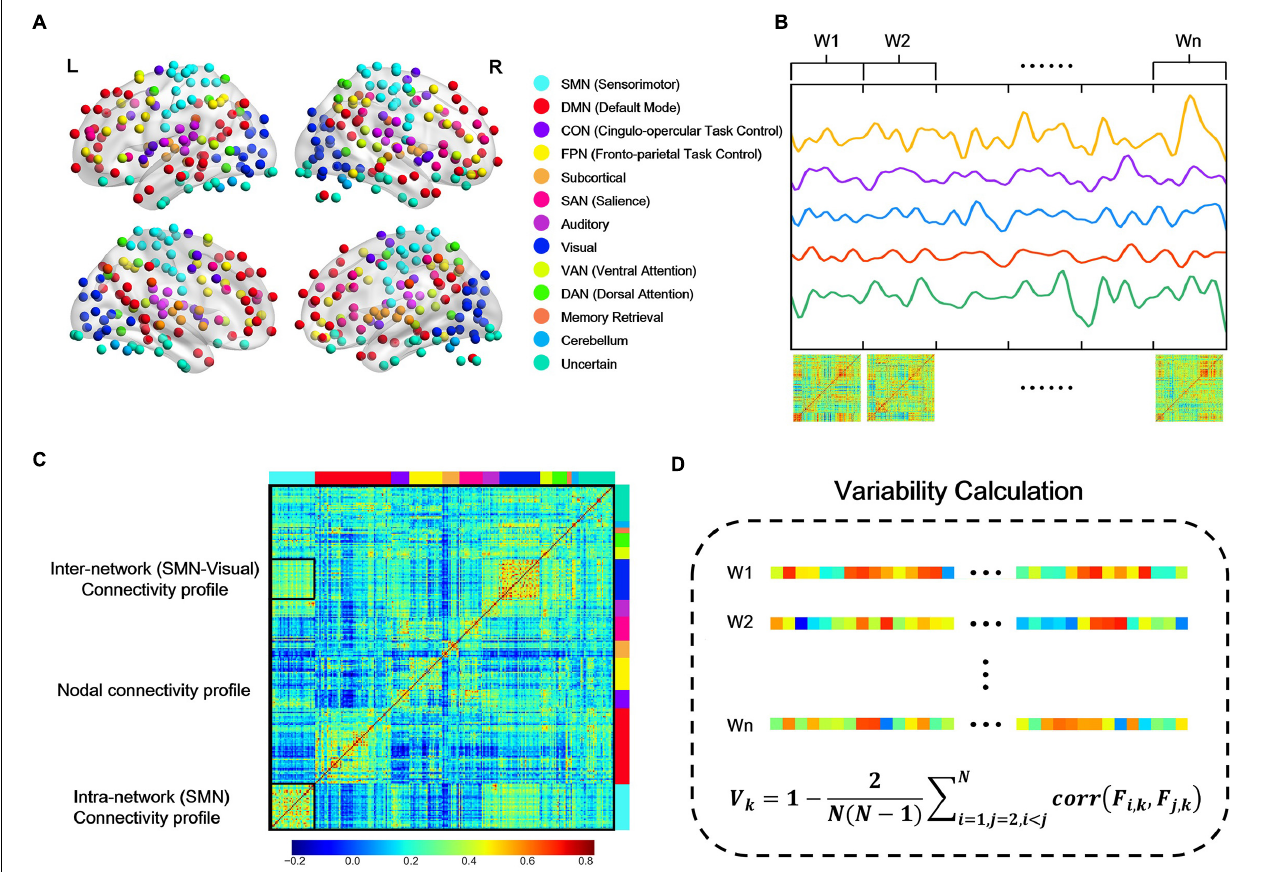
FIGURE 1 | Schematic overview of the temporal variability calculation. (A) Network partition of 264 putative functional regions defined by Power et al. (2011) L, Left; R, right. (B) Each regional BOLD signal was segmented into non-overlapping windows, and the whole brain functional connectivity network was constructed using Pearson correlation of the representation BOLD time series in each window. (C) From the raw functional connectivity matrix in one time window, nodal connectivity profile is the vector that describes its connectivity with all the other nodes (e.g., the column marked by black line); intra-subnetwork connectivity profile is the upper triangle (due to symmetry) of the connectivity matrix within one subnetwork (e.g., SMN); inter-network connectivity profile is the connectivity matrix between two subnetworks (e.g., SMN-visual, as the block marked by a small black rectangular window). (D) Calculation of temporal variability. The nodal, intra- and inter-network connectivity profile in each window was unfolded into connectivity vectors, respectively, and the temporal variability was calculated as the average correlation coefficients of the connectivity vectors across different windows with a deduction from